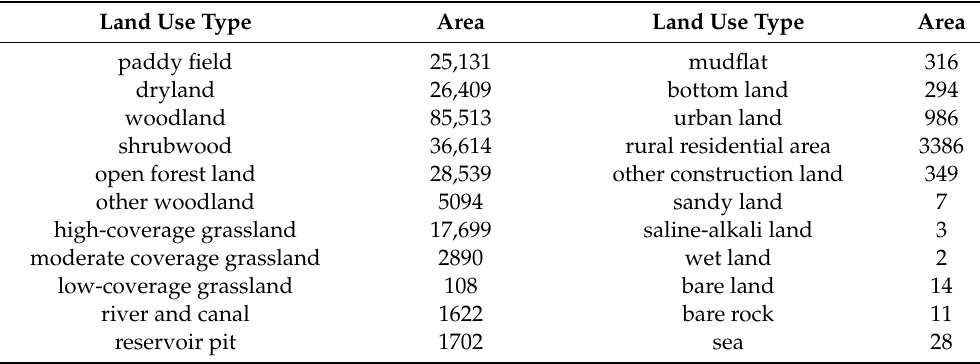
Figure 3. Location of Guangxi ( a ) and the spatial distribution map of land use types ( b ) in Guangxi 2010. Table 2. Land use type area in 2010 (unit: km 2